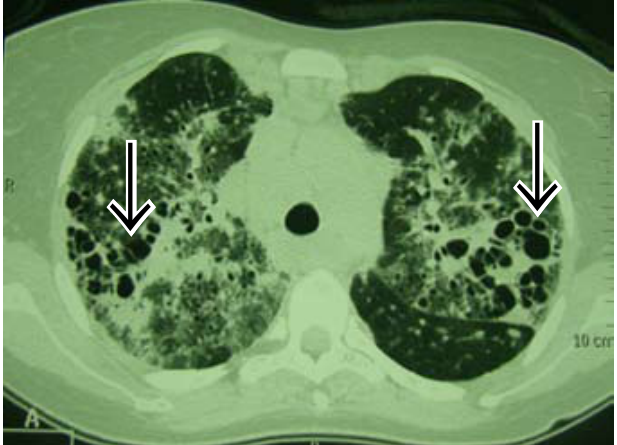
Fig. 11b. Axial HRCT of the same patient showing interstitial fibrosis and cystic changes.